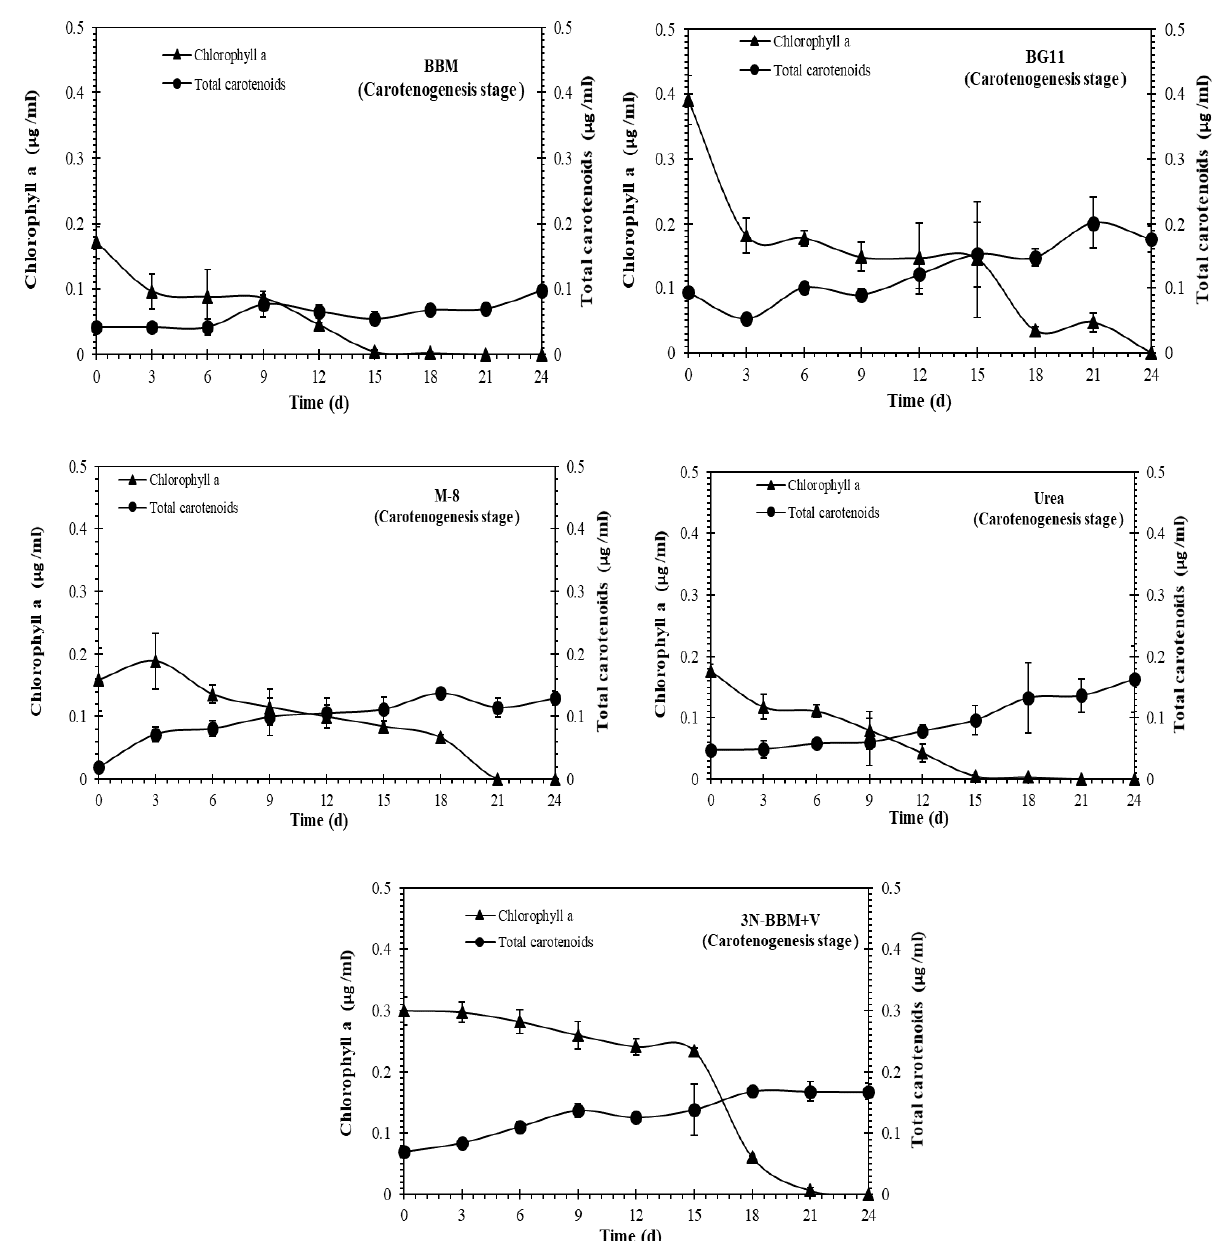
Figure 4. Chlorophyll a and carotenoids production in Coelastrella sp. in the carotenogenesis stage. After pre- cultivation in 5 standard medias at 40 μmol m −2 s −1 , 16:8 (light:dark) photoperiod for 12 days, algal cells were transferred and cultured for 24 days on the BG-11 medium without nitrate, with the addition of 0.15 M NaCl and 24 h light at 240 μmol m −2 s −1 . Cultures were maintained in a mixed state by bubbling with a mixture of 3% CO 2 in N 2 . Results represent mean ± SD of three replicates.